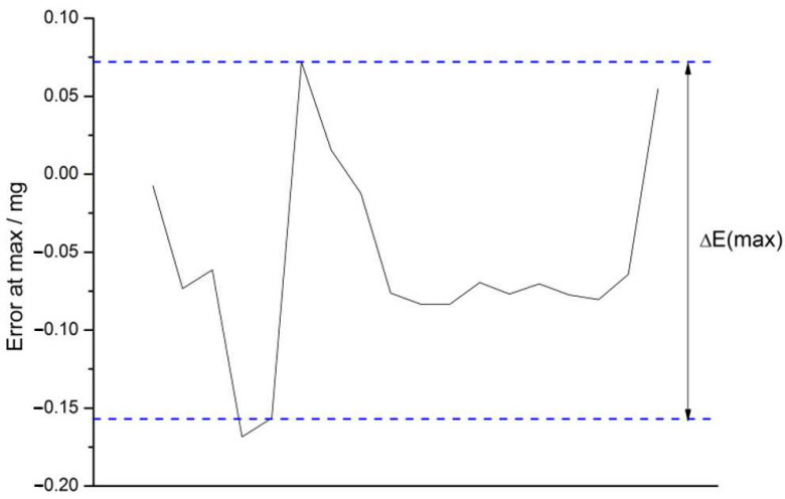
Figure 9. Errors variation between calibrations at 50 g .